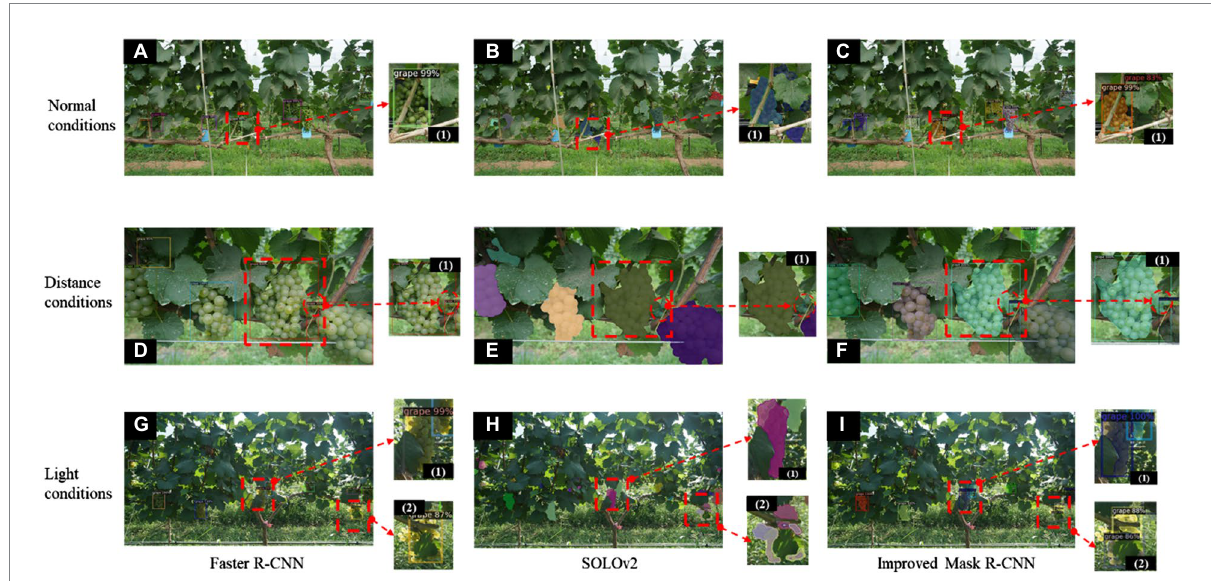
FIGURE 10 Comparative results of the improved Mask R-CNN model with Faster R-CNN and SOLOv2 under different conditions. (A–C) are the prediction results of Faster R-CNN, SOLOv2, and improved Mask R-CNN under normal conditions, respectively. (D–F) are the prediction results of Faster R-CNN, SOLOv2, and improved Mask R-CNN under distance conditions, respectively. (G–I) are the prediction results of Faster R-CNN, SOLOv2, and improved Mask R-CNN under light conditions, respectively. (1,2) are partial enlargements of the instance segmentation results of the corresponding images,